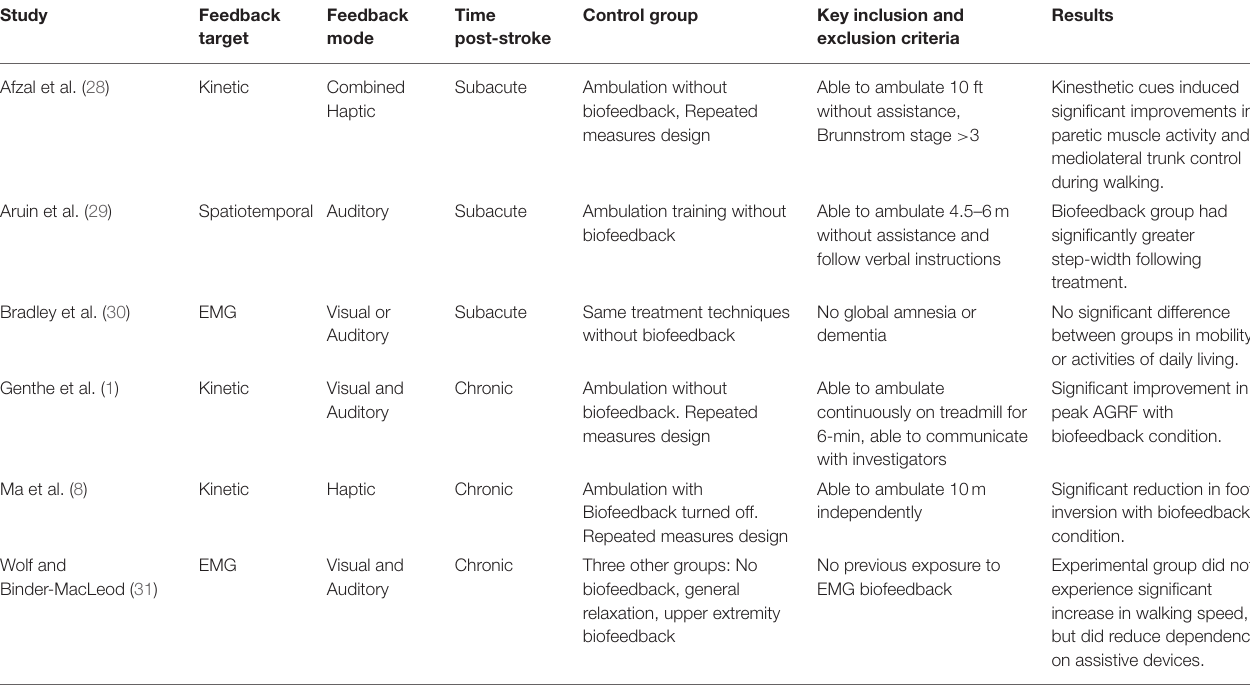
TABLE 2 | Summary of relevant characteristics of other selected